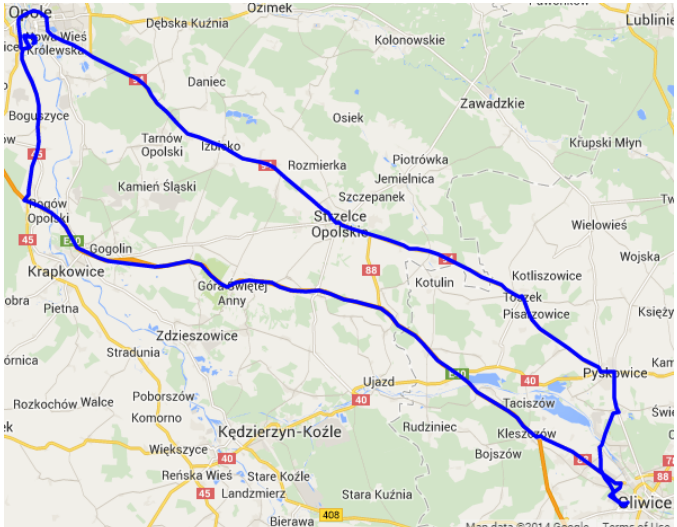
Figure 10. Daily GPS trace of a single user (Experiment 1). Map data c (cid:13) 2014 by Google.